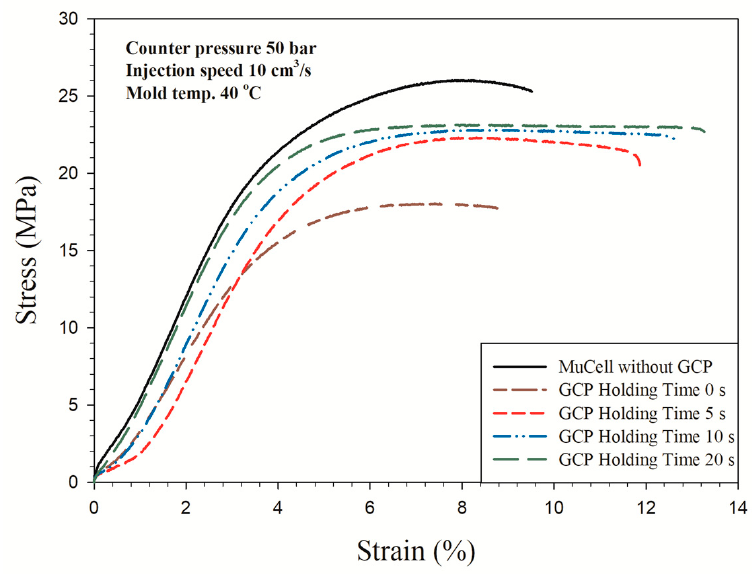
Figure 12. Stress–strain curves of microcellular injection-molded PP with GCP of 50 bar and different holding times.